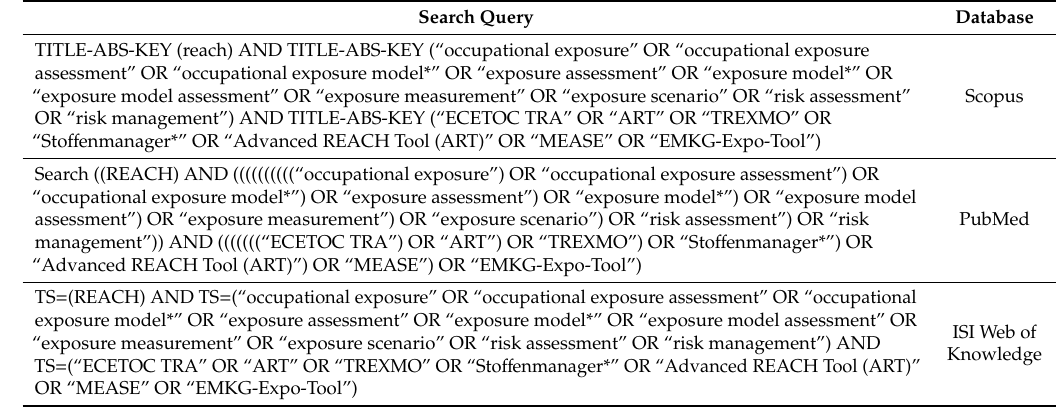
Table 1. Query used for the search in three di ff erent databases: Scopus, PubMed, and ISI Web of Knowledge (last search: 16 January 2019; weekly updates were performed until the date of submission of